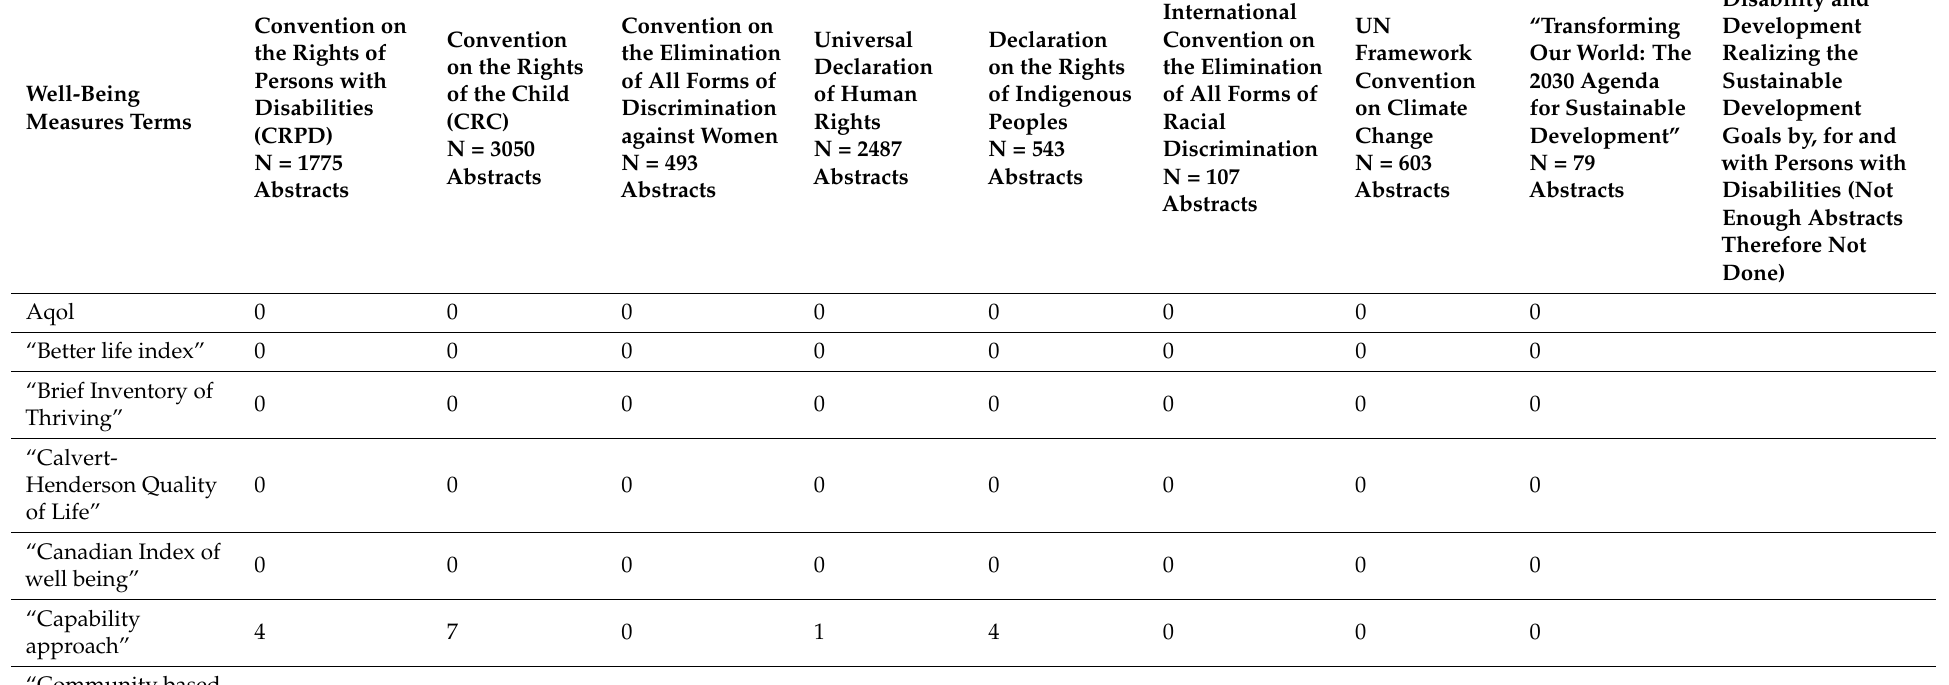
Table 10. Hit counts for the terms used for 21 “well-being measures” in abstracts mentioning “the